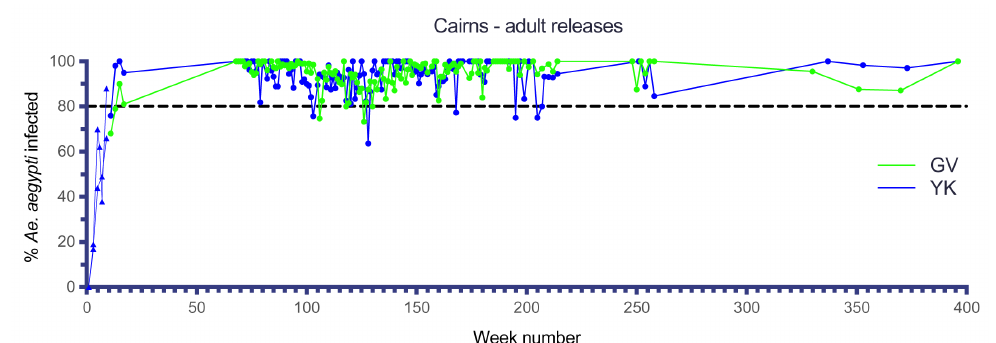
Figure 6. Wolbachia infection rates in Aedes aegypti mosquitoes collected from Gordonvale (GV) and Yorkeys Knob (YK) during release (triangles) and post-release (circles) monitoring periods. Collections to week 17 from ovitraps, collections from BG Traps thereafter ( Wolbachia infected adult mosquito releases undertaken weekly for 10 weeks between Jan–Feb 2011, Week number 1 corresponds to commencement of Wolbachia mosquito releases in each location).